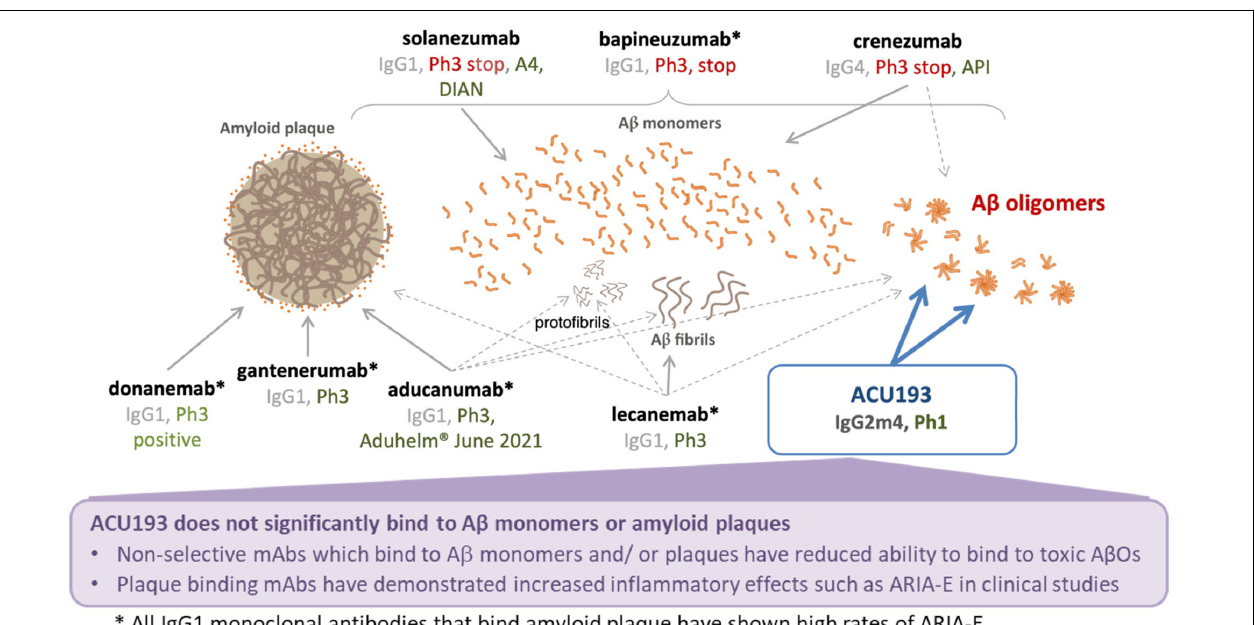
Frontiers in Neuroscience |